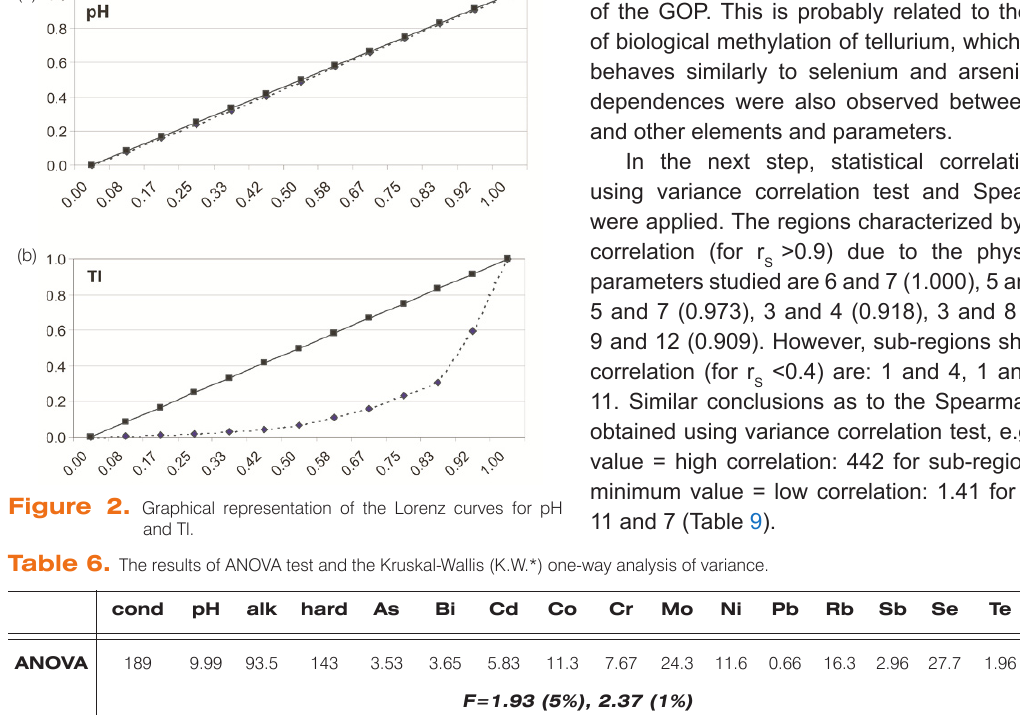
Table 7. The Mann–Whitney U test; s-r –sub-region number, H